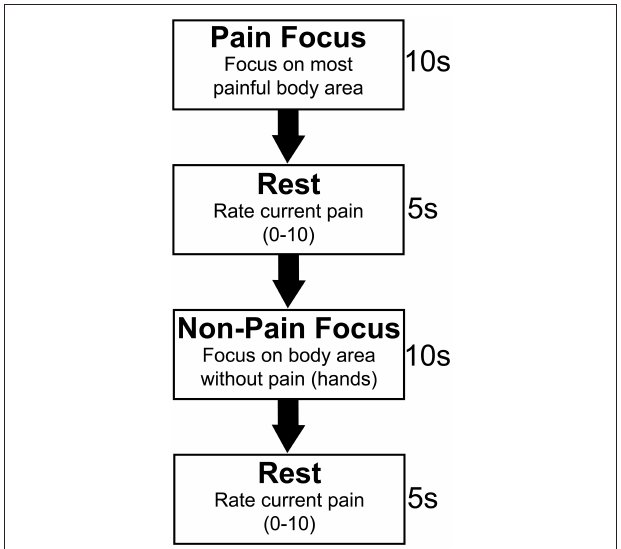
FIGURE 1 | Somatosensory focus task paradigm. Pain subjects were asked to alternate between two active focus periods of 10s. For the first focus period, the pain focus, subjects were asked to focus only on their most painful area. Subjects were asked to focus on their intrinsic somatosensation in a body area in which they did not have pain symptoms for the second, non-pain focus period. This was the hands for all subjects. Five second rest periods separated focus periods during which time pain subjects verbally rated their pain on a 0–10 rating scale. Control subjects were asked to focus on the intrinsic somatosensation in the same two body areas as their age, sex, and injury level matched pain group counterpart.